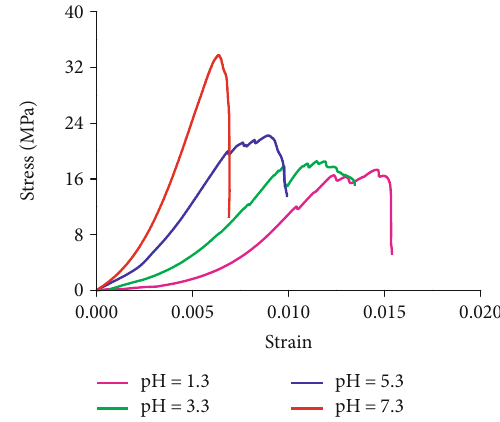
Figure 3: Stress strain of rock after soaking at di ff erent